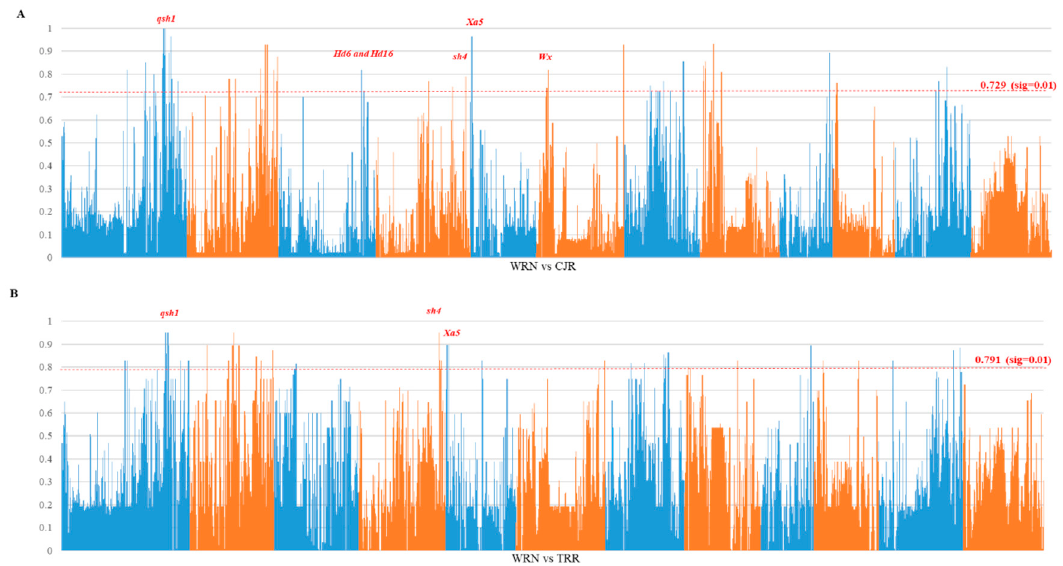
Figure 4. Genomic divergence between WRN and each of two control groups. Histogram based on a 100 kb sliding-window F ST comparisons between ( A ) WRN and CJR and ( B ) WRN and TRR. The dotted red line indicates the cutoff for the top 1% of windows.